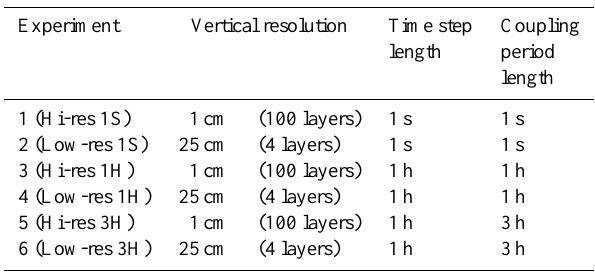
Table 1. Initial experiments comparing CICE under six different